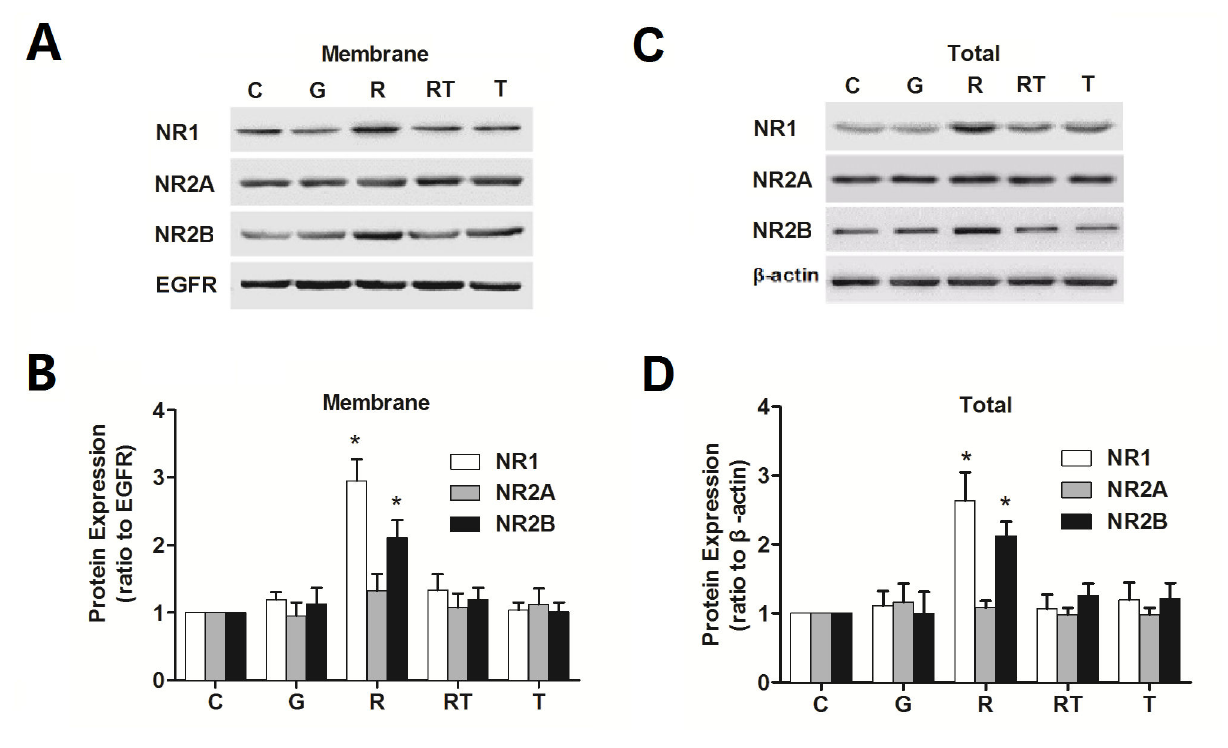
Figure 3. GSK-3β regulates the expression of NMDA receptors in spinal dorsal horn. Western blot for membrane NR1, NR2A and NR2B subunit was performed on rat spinal cord dorsal horn neuron (A). Epidermal growth factor receptor (EGFR) was used as the loading control. Pooled densitometric results for NR1, NR2A and NR2B, with the band intensity of C group assigned the value of 1. Remifentanil induced significant increases of both membrane NR1 and NR2B, but had no effect on membrane protein level of NR2A. GSK-3β inhibitor TDZD-8 prevented the changes of membrane NR1 and NR2B. n = 5 for each group, compared with C group, * P < 0.05, ANOVA (B). The expression of total NR1, NR2A and NR2B protein in spinal dorsal horn was tested by Western blot (C). β-actin was used as the loading control. Densitometry measurements from 5 groups were pooled and the band intensity of C group was assigned a value of 1. Remifentanil increased the total protein level of NR1 and NR2B, but had no effect on total protein level of NR2A. TDZD-8 prevented the changes of total protein expression of NR1 and NR2B (D). n = 5 for each group, compared with C group, * P < 0.05,